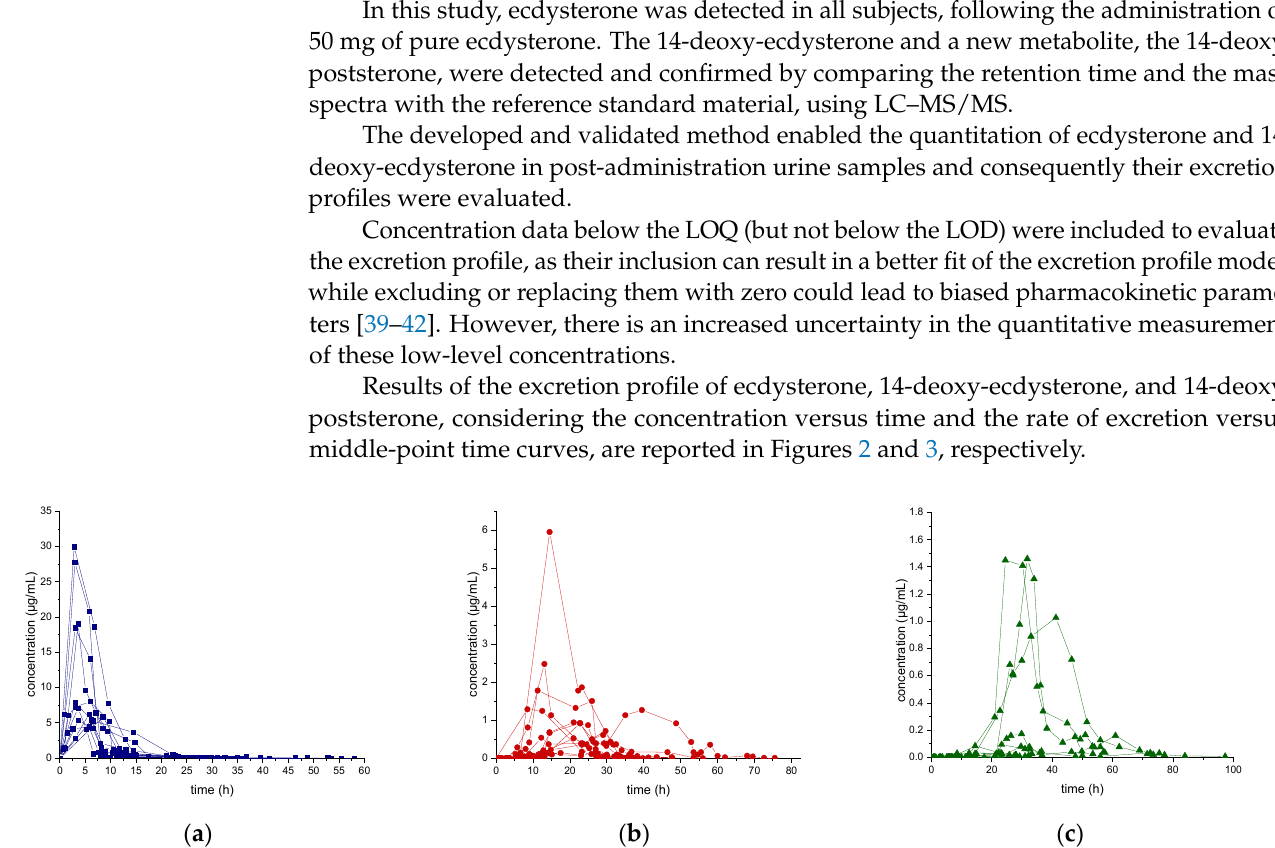
Figure 2. Urinary excretion profile (concentration-time curve) of ecdysterone ( a ), 14-deoxy-ecdysterone ( b ), and 14-deoxy- poststerone ( c ), following a single-dose administration of 50 mg of pure ecdysterone in humans ( n = 12).